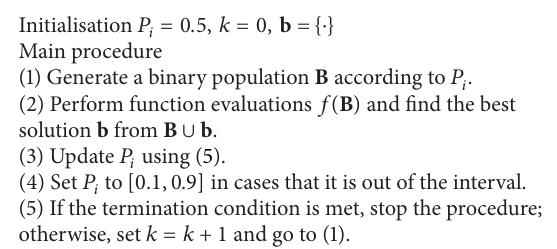
Initialisation 𝑃 𝑖 = 0.5 , 𝑘 = 0 , b ={⋅}